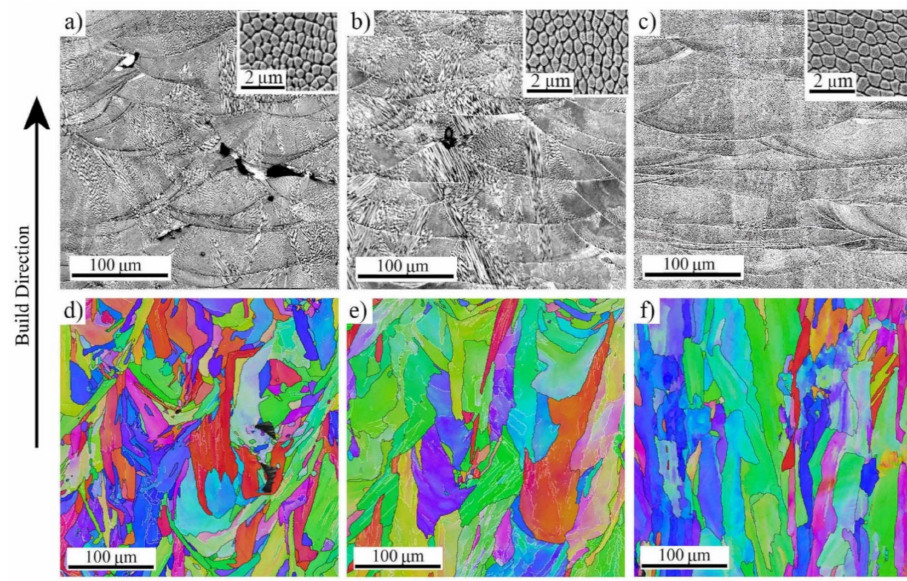
Figure 2. Laser optical and EBSD IPF images of 316L fabricated with ( a , d ) low-VED; ( b , e ) medium- VED; ( c , f ) high-VED. Inserts in a, b, and c display the average cell structure captured with SEM in the same